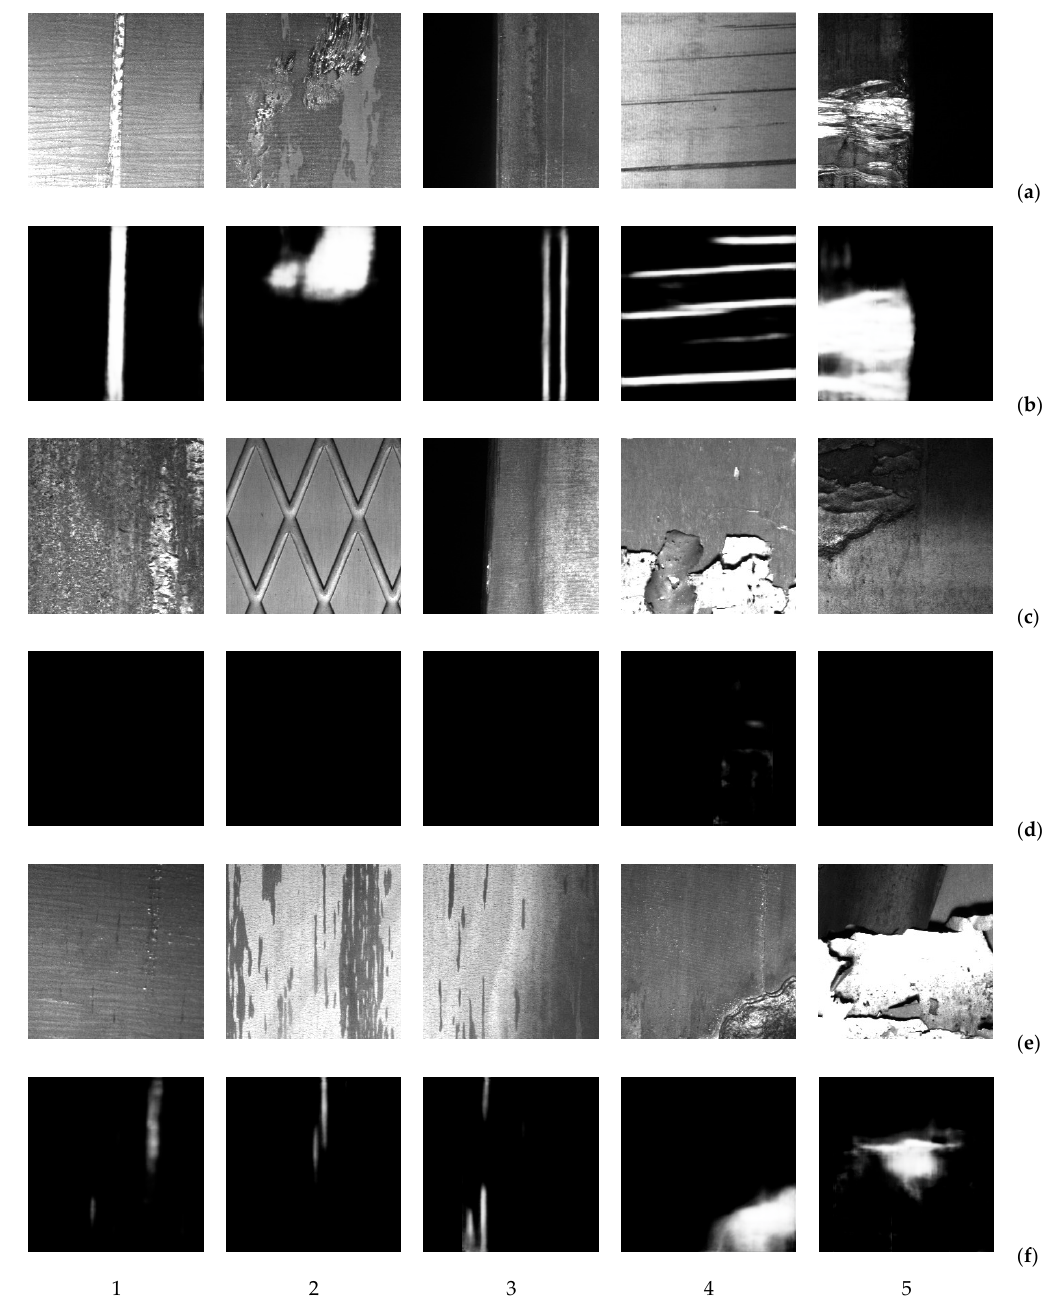
Figure 7. Examples of test images with damage such as “scratch abrasion” ( a ), and the results of their recognition using model 2 ( b ); examples of defect-free surfaces ( c ), and the result of their recognition ( d ); examples of erroneous recognition of defects ( e , f ).